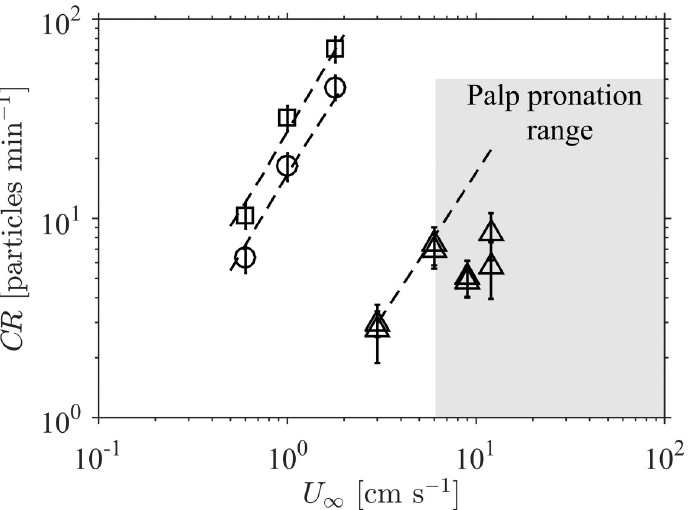
Fig 3. The impact of flow velocity on contact rate for both rigid and flexible collectors. Markers represent experimental data as per Table 2: single rigid cylinder with diameters of 6 mm ( □ ) and 25 mm ( ○ ) [14] and flexible polychaetes ( 4 ) [17], with uncertainty as reported. Broken lines represent numerical model predictions of the contact rate variation. When the collectors do not experience flow-induced pronation (which, for the experimental polychaetes palps, occurred at velocities above 6 cm s -1 , [17]), the predictive model performs excellently.